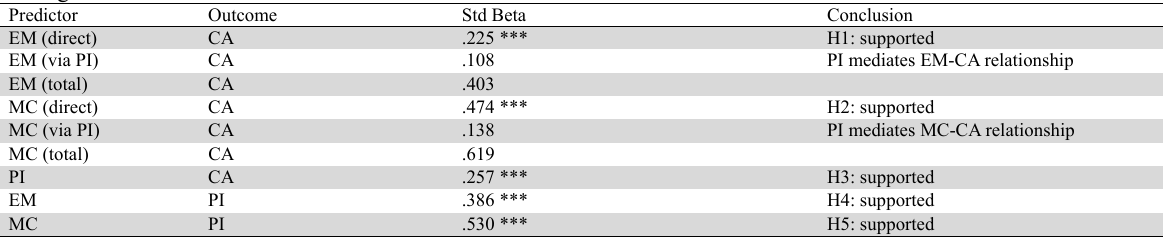
Findings from SEM